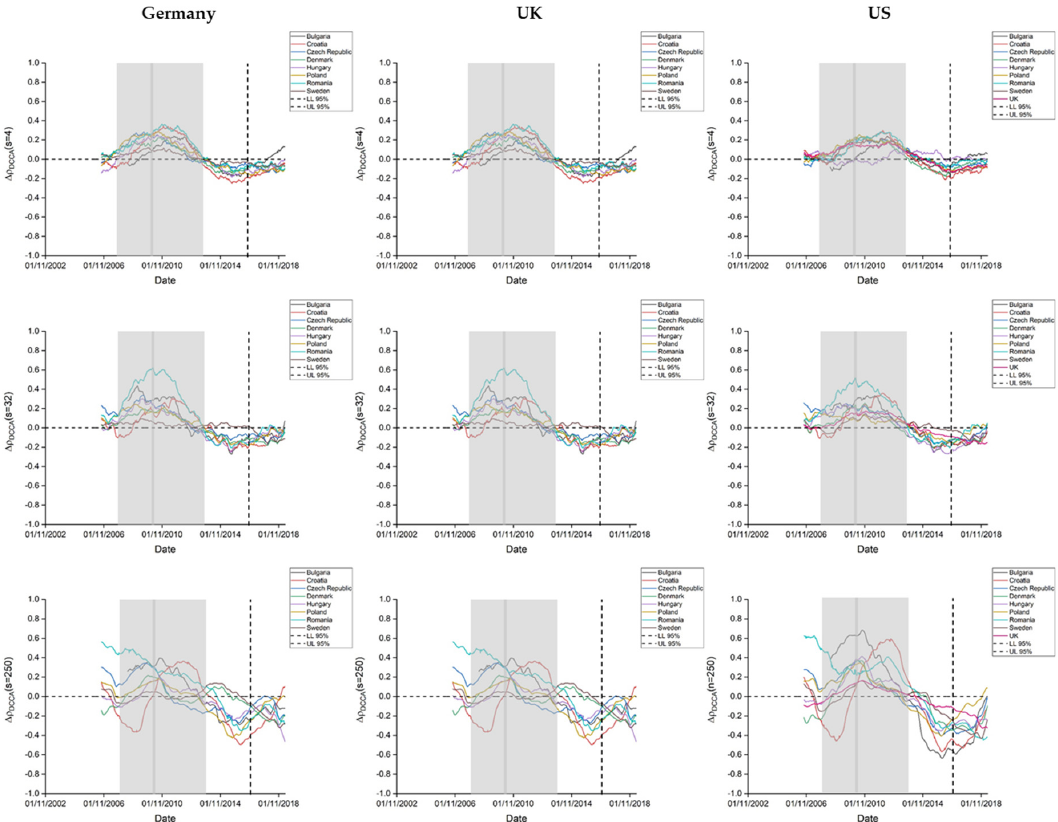
Figure 8. Evolution of the ∆ ρ DCCA between non-Eurozone stock markets and Germany ( left panel ), the UK ( middle panel ), and the US ( right panel ), for time scales of 4, 32, and 250 days, considering that ∆ ρ DCCA ( 1 ) = ρ DCCA ( 1001 ) − ρ DCCA ( 1 ) . LL and UL are, respectively, the lower and upper limits of the confidence interval. Shaded areas represent the global financial crisis and the Eurozone debt crisis. The vertical dashed line refers to the moment of the Brexit referendum.